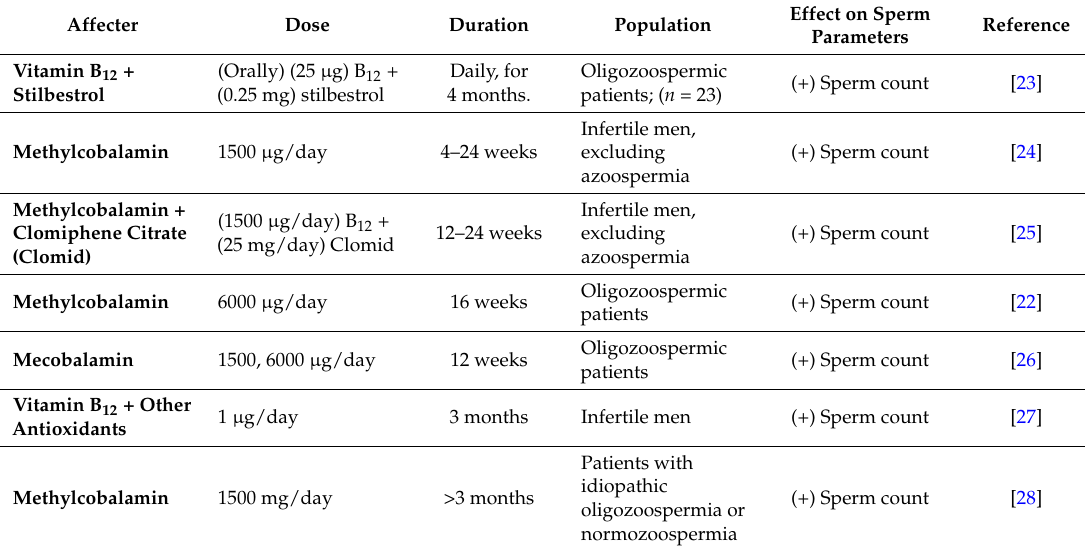
Table 1. Effect of vitamin B 12 or its derived compounds on human sperm